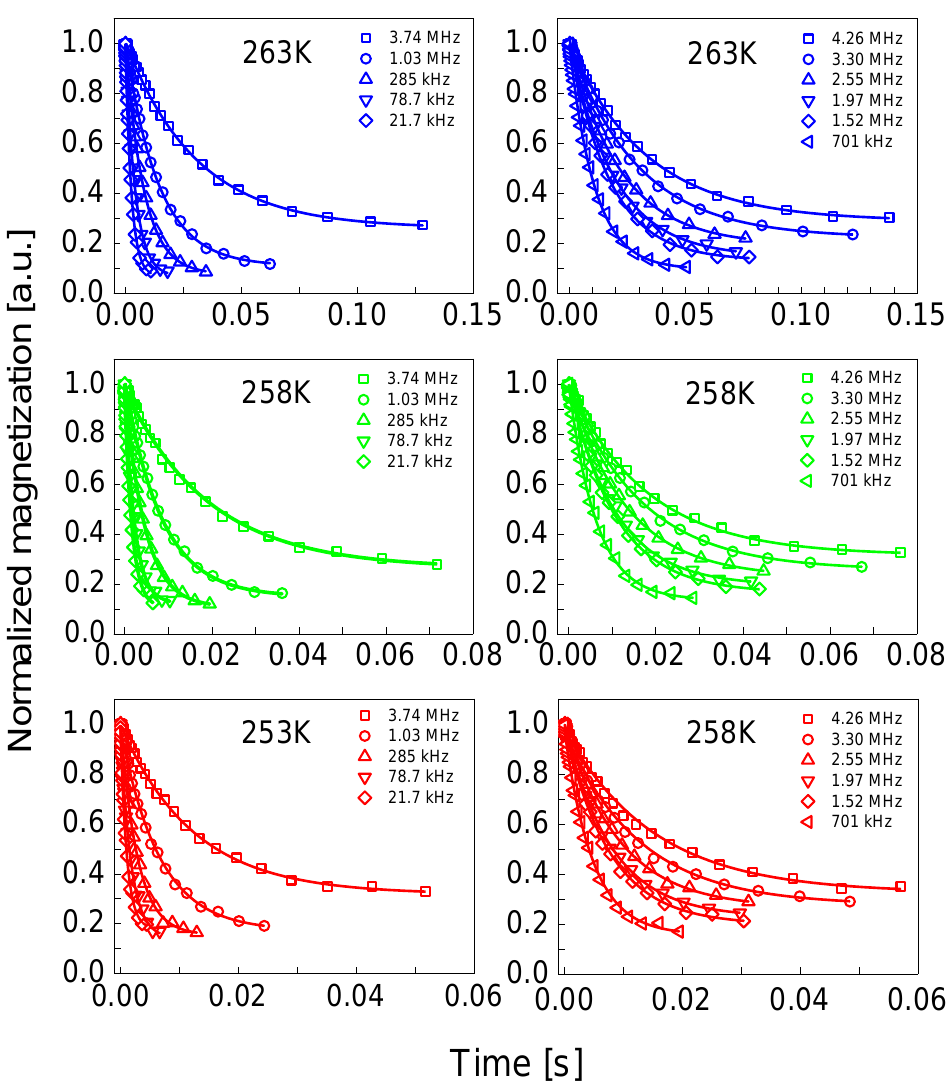
Figure A3. Normalized 1 H magnetization curves for BSA–water mixture (20%wt BSA) at selected resonance frequencies in the temperature range from 263 K to 253 K. Solid lines—single exponential fits. On the left frequencies are selected from the entire range measured and, on the right, only from areas with quadrupole peaks.